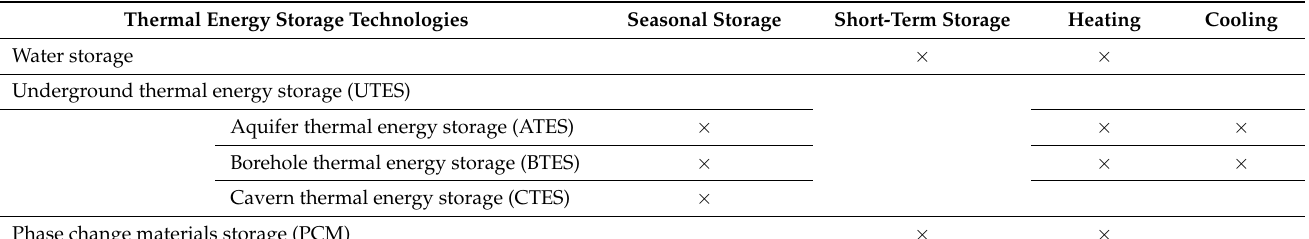
Table 1. Applications of the main thermal energy storage technologies in closed greenhouses [27]. Thermal Energy Storage Technologies Seasonal Storage Short-Term Storage